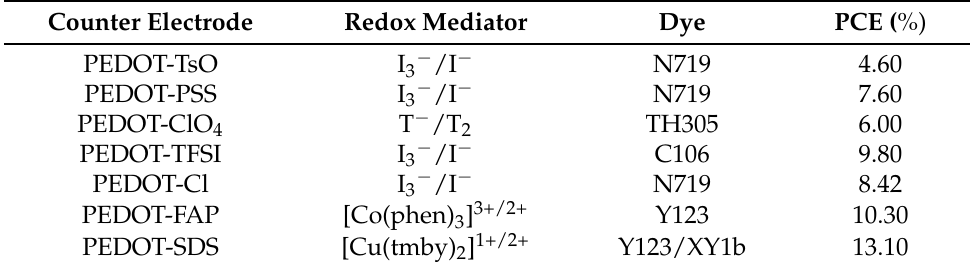
Table 5. Selected photovoltaic performance of PEDOT-based DSSCs with differing redox mediators and dyes. Reprinted from [45] under a Creative Common CC BY